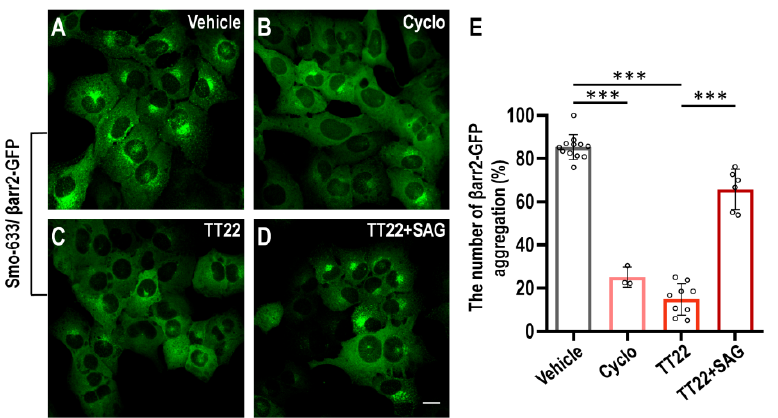
Figure 3. Novel Smo inhibitors were identified in U2OS cells. ( A – D ) The U2OS cells stably overexpressing β arr2-GFP and Smo-633 were treated with DMSO vehicle ( A ), 1 μ M cyclopamine (Cyclo) ( B ), 100 nM TT22 ( C ), or 100 nM TT22 and 1 μ M SAG ( D ) for 24 h at 37 °C. The arrows show the intravesicular aggregation of β arr2-GFP. ( E ) The percentage of the number of β arr2-GFP aggregation was quantitated. The scale bar is 20 μ m. All data are means ± SEM (one-way ANOVA). *** p < 0.001.